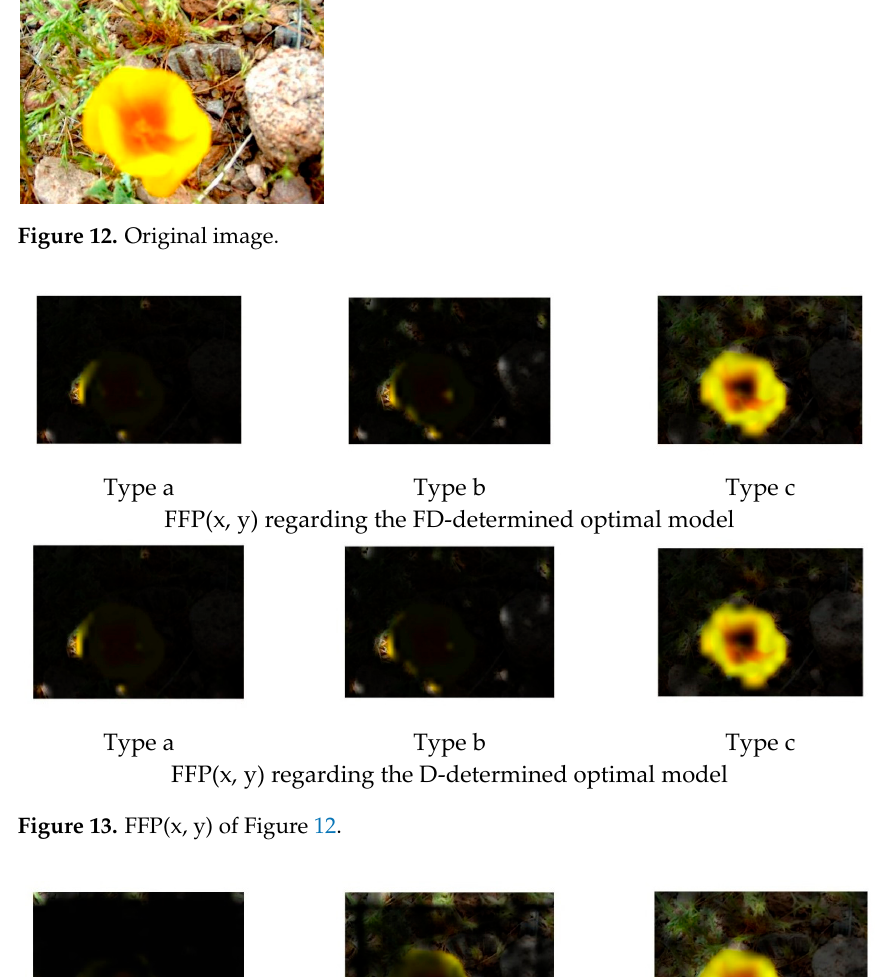
AIR(x, y) regarding the FD-determined optimal model Figure 14.